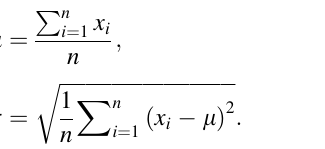
Total Total time position